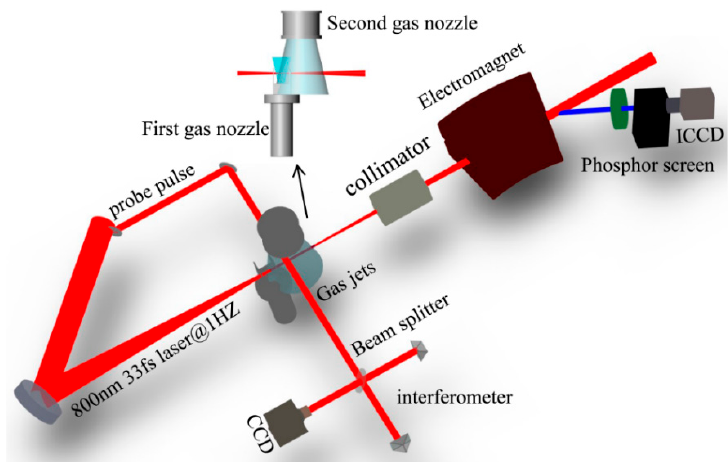
Figure 1. Experimental layout of the hybrid laser-plasma wakefield accelerator. CCD: charge-coupled device; ICCD: intensified charge-coupled device.